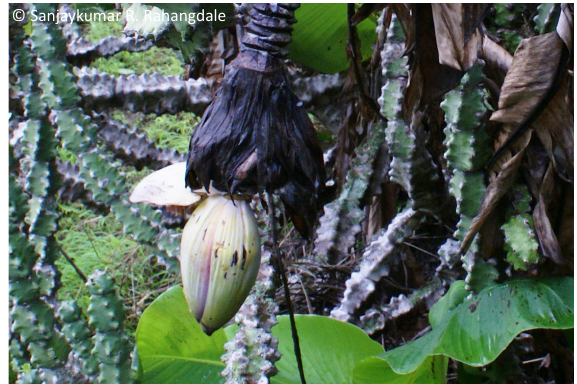
Image 3. Healthy flower and fruiting of Ensete superbum at non- harvesting site